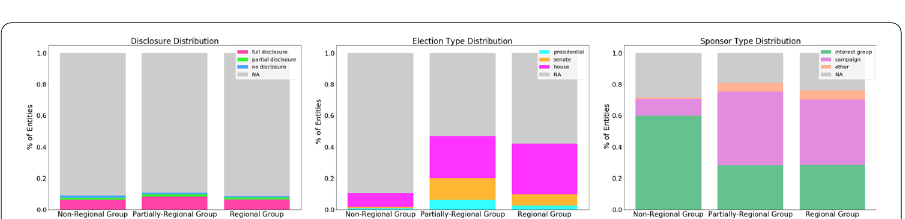
Fig. 7 Partition group makeup by disclosure type (left), election type (middle), and sponsor type